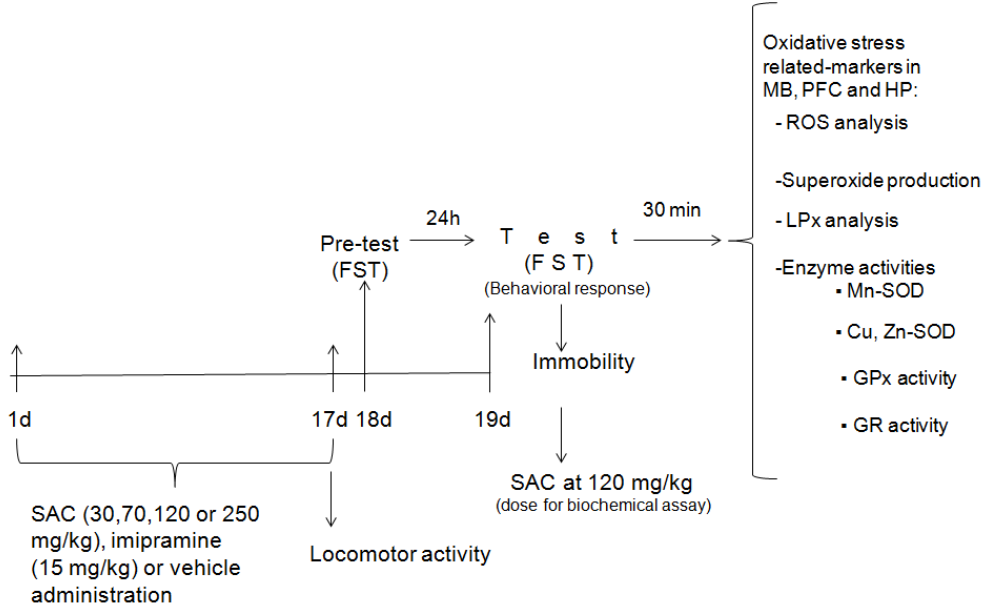
Figure 1. Schematic experimental protocol. FST = forced swimming test; SAC = S-allyl cysteine; MB